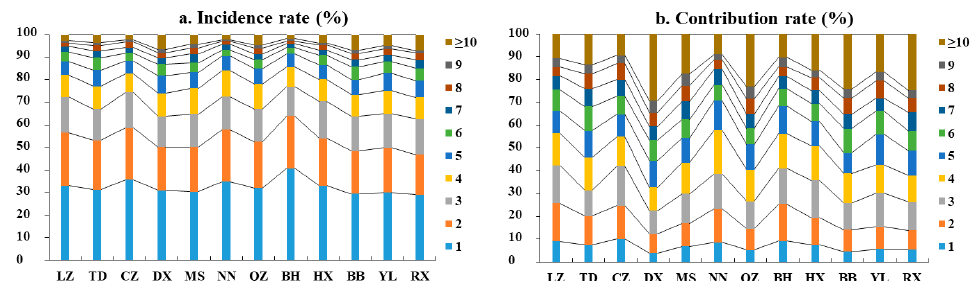
Figure 4. Incidence rates ( a ) and contribution rates ( b ) of different precipitation duration in rainy season at 12 stations in the Beibu Gulf. The letters along the x -axis denote names of the weather stations: Longzhou (LZ), Tiandeng (TD), Chongzuo (CZ), Dongxing (DX), Mashan (MS), Nanning (NN), Qinzhou (QZ), Beihai (BH), Hengxian (HX), Bobai (BB), Yulin (YL) and Rongxian (RX).